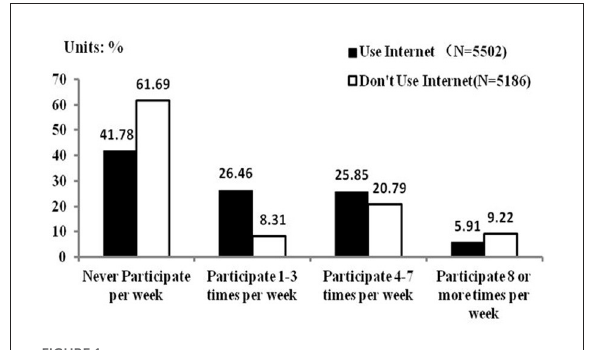
FIGURE1 Sport participation rate of residents using/not using the